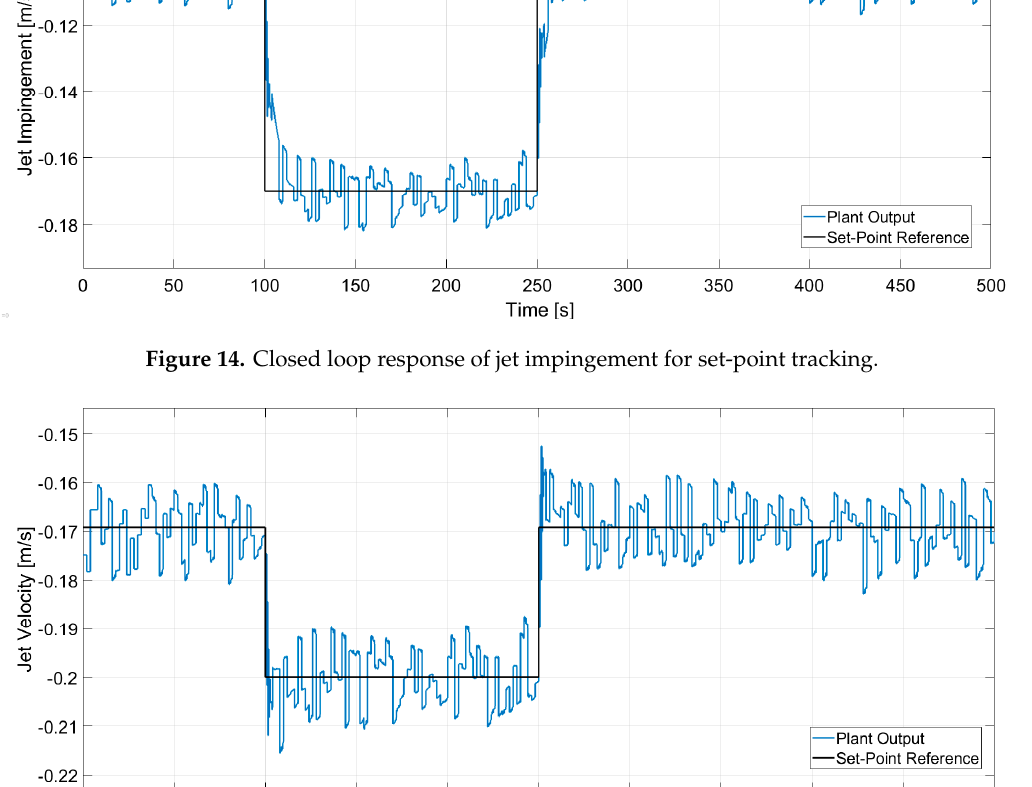
Figure 15. Closed loop response of jet velocity for set-point tracking.